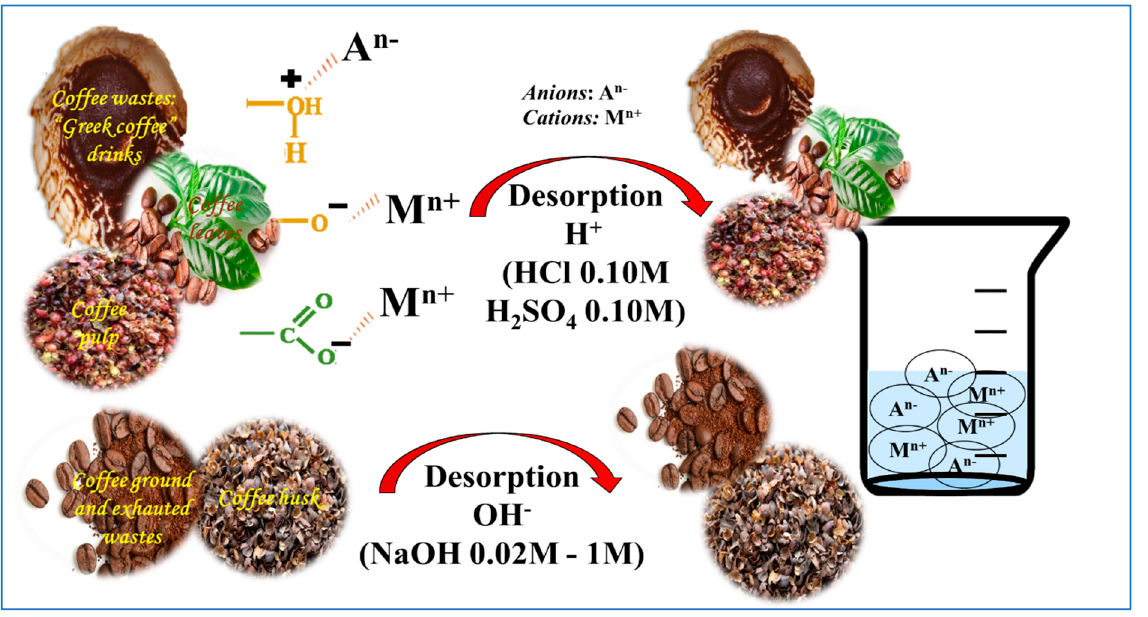
Figure 5. Desorption mechanisms of anionic and cationic species using sorbents derived from coffee cultivation and processing.